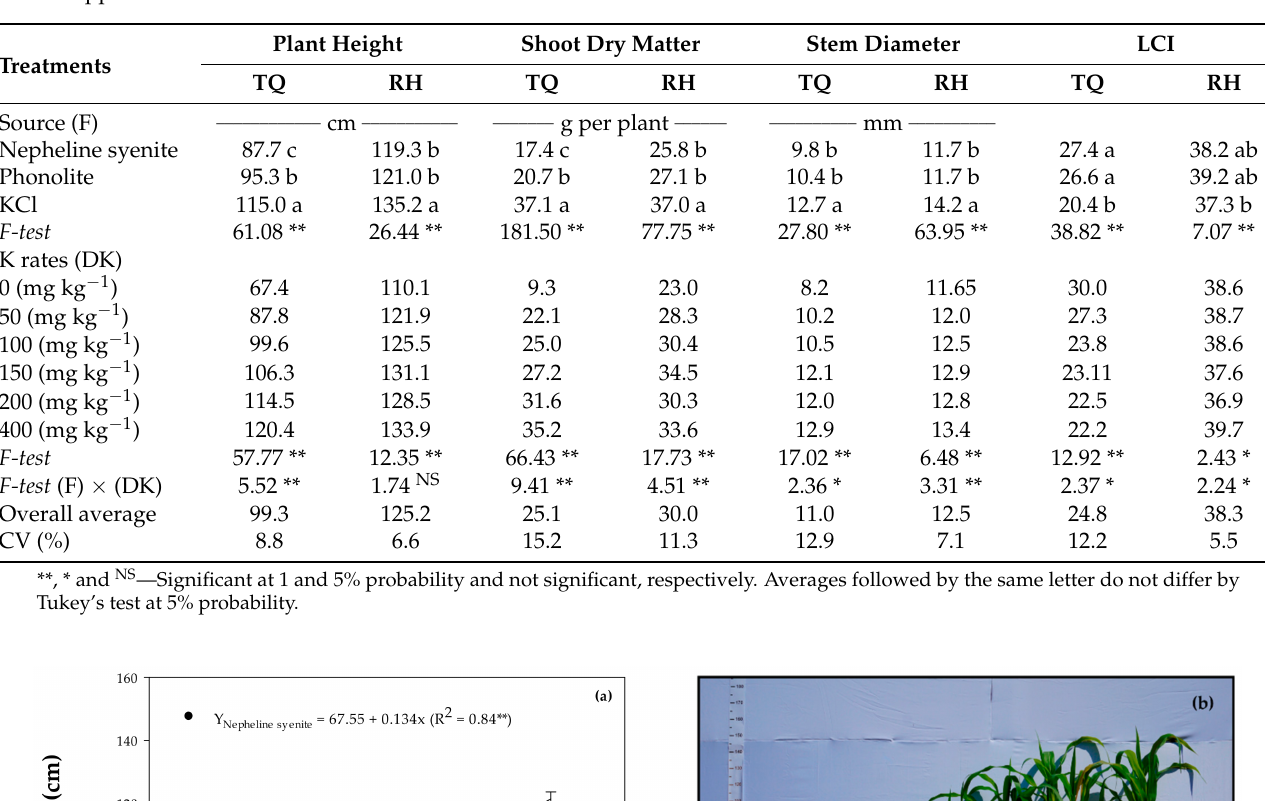
Figure 1. Shoot K accumulation of maize plants grown in the Typic Quartzipsamment ( a ) and in the Rhodic Hapludox ( b ), depending on the rates and sources of K. **—Significant at the p < 0.01 level. Bars represent the standard error of the mean. Table 12. Effect of treatments on plant height, shoot dry matter, stem diameter, and leaf chlorophyll index (LCI), 45 days after the emergence of maize plants grown in the Typic Quartzipsamment (TQ) and in the Rhodic Hapludox (RH), depending on the application of K sources and